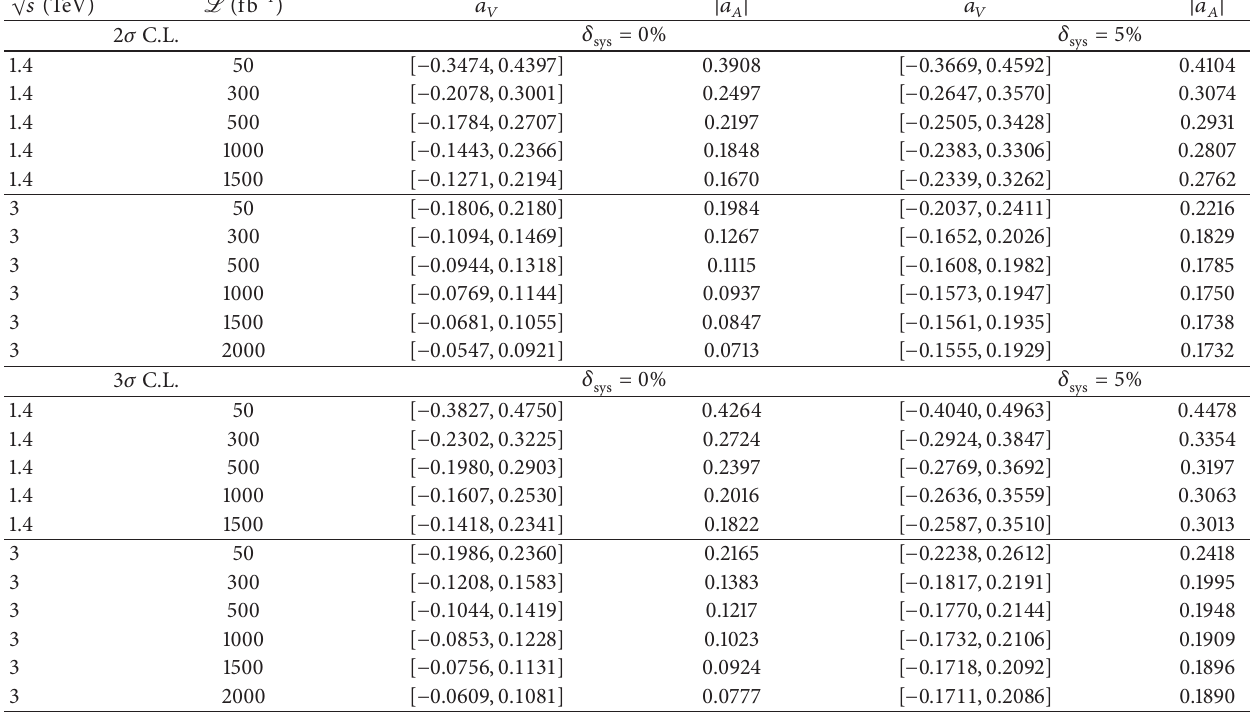
Table 4: Bounds on the ̂𝑎 𝑉 magnetic moment and ̂𝑎 𝐴 electric dipole moment for the process 𝑒 + 𝑒 − → 𝑒 + 𝛾 ∗ 𝑒 − → 𝑡𝑏 ] 𝑒 𝑒 + ( 𝛾 ∗ is the